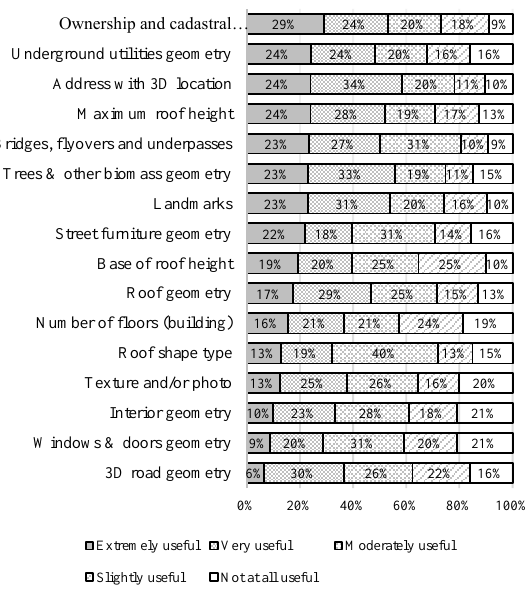
Figure 3. Stacked bar chart showing the aggregated results from question 3 as a percentage split of UK-only responses –